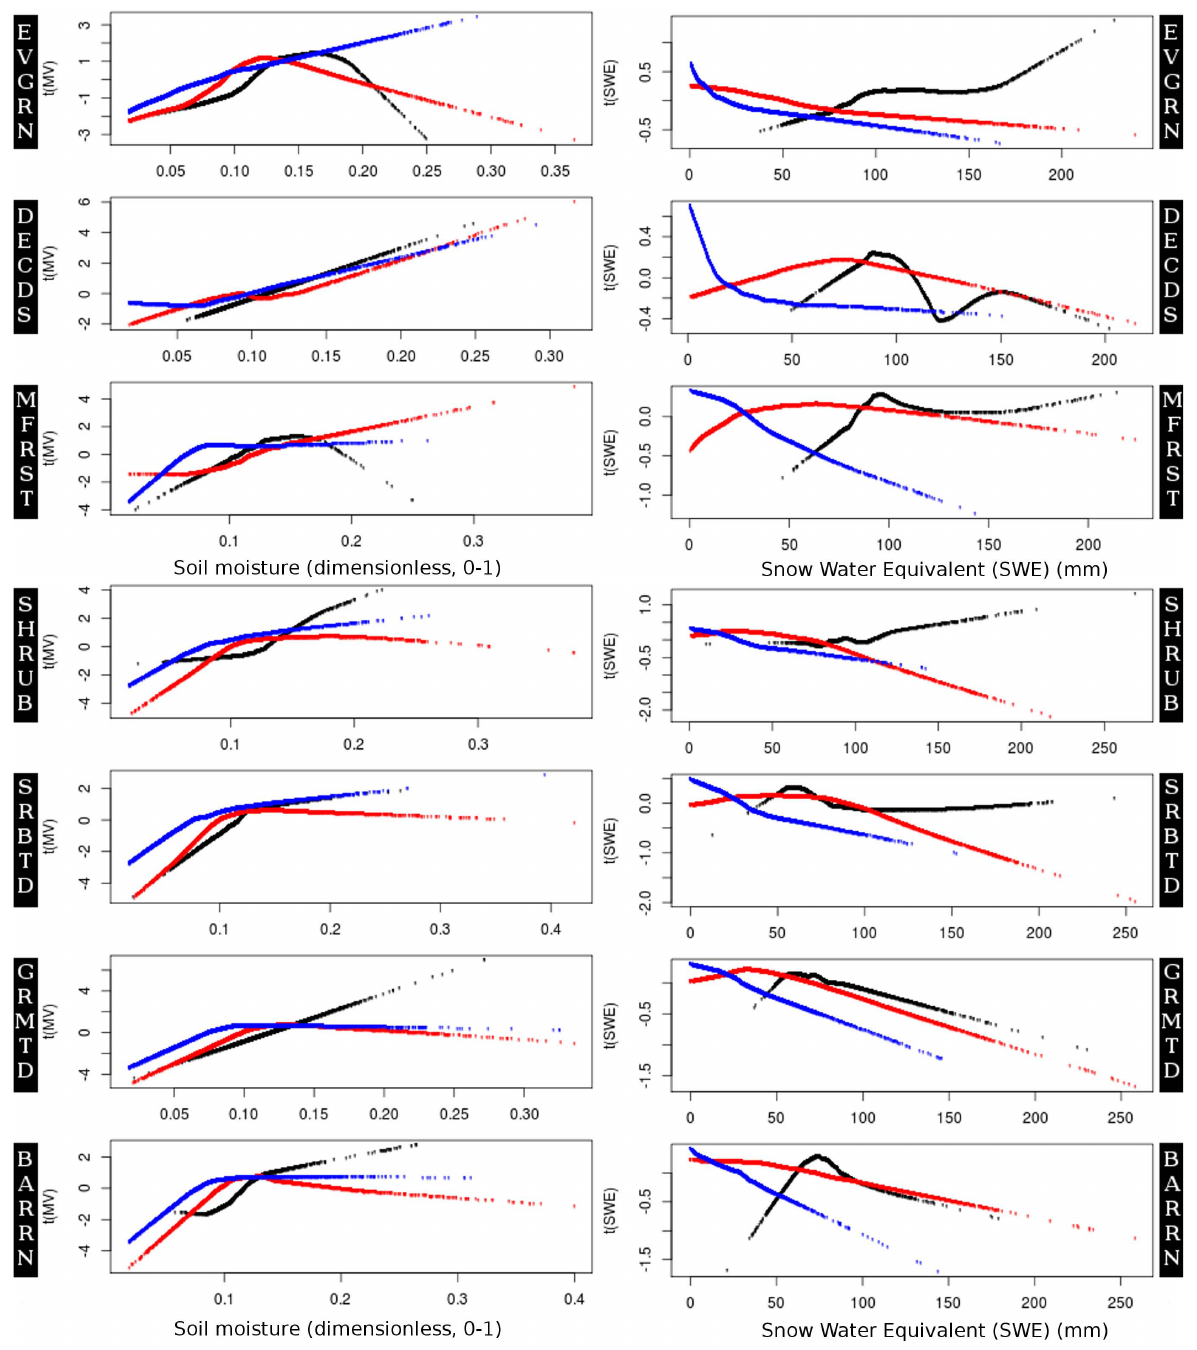
Fig. 5. a–c: Linkages between SWE and volumetric soil moisture (MV), as indicated by the optimal transformations identified using the ACE approach. The point pairs [MV, t (MV)] and [SWE, t (SWE)] were independently calculated for each forest vegetation class shown here. Associations between mean 2003–2008 values are shown in black, and associations in “spring” and “autumn” are shown in red and blue. d–g: Linkages between SWE and volumetric soil moisture (MV), as indicated by the optimal transformations identified using the ACE approach. The point pairs [MV, t (MV)] and [SWE, t (SWE)] were independently calculated for each non-forest vegetation class shown here. Associations between mean 2003–2008 values are shown in black, and associations in “spring” and “autumn” are shown in red and